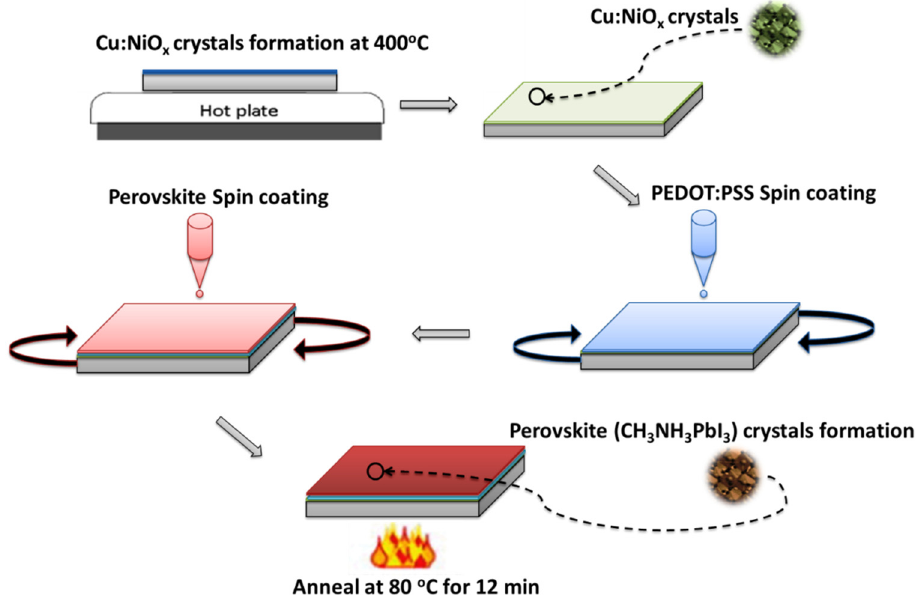
Figure 2. Schematic of the stages involved in copper-doped nickel oxide (Cu:NiOx) and perovskite crystallization.